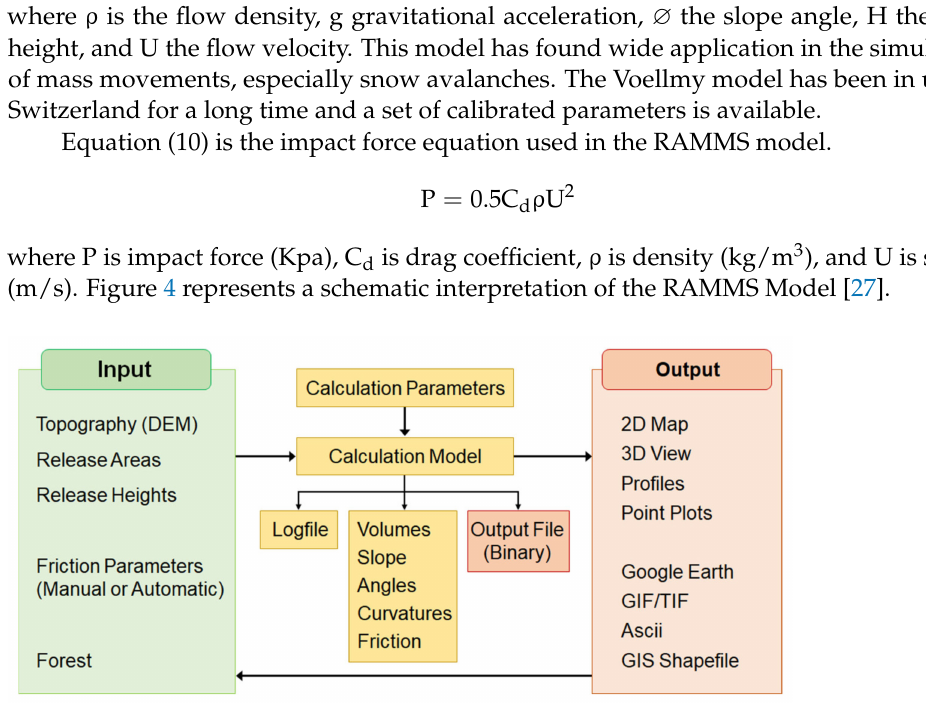
Figure 4. A schematic interpretation of the RAMMS